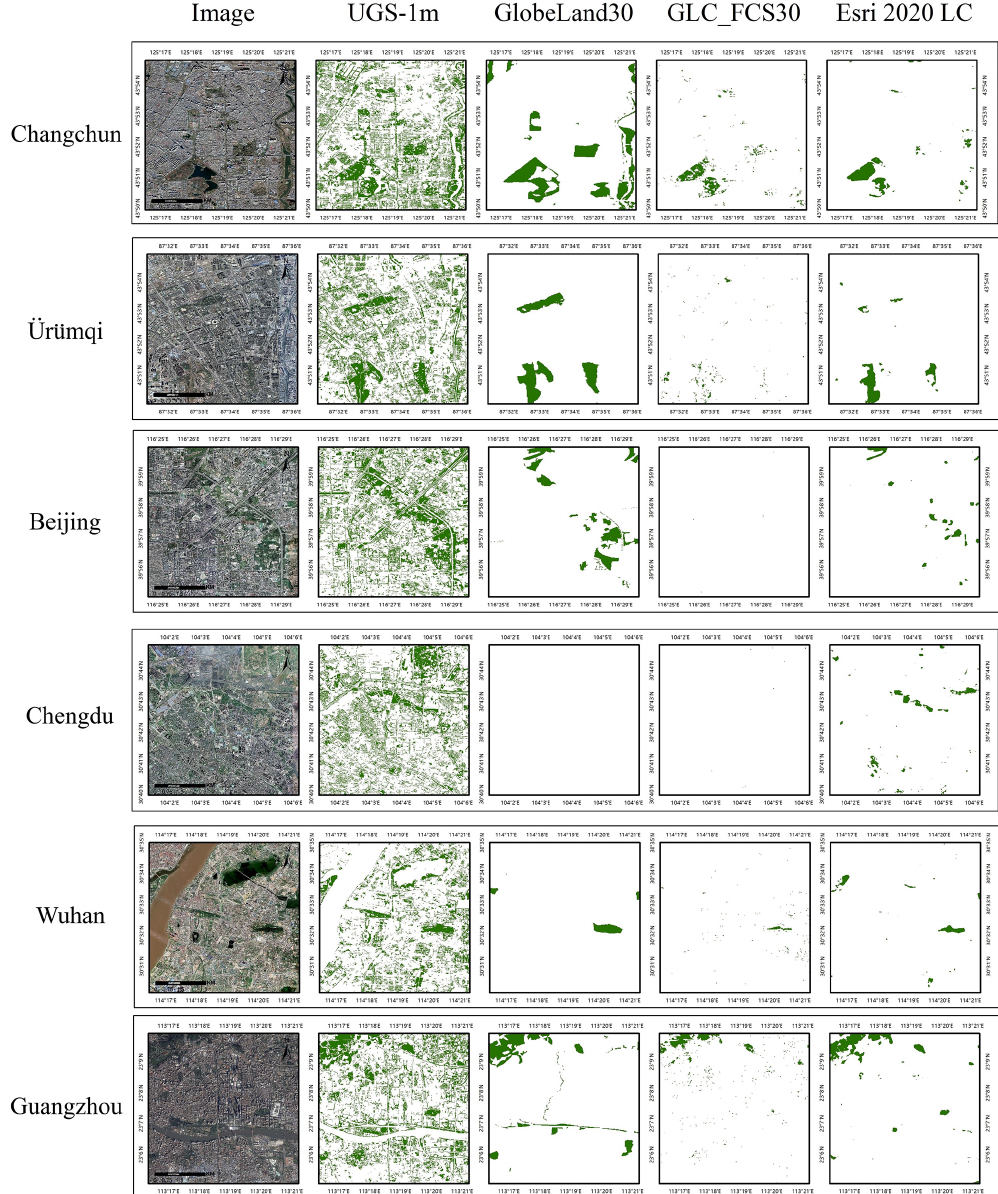
Figure 16. Visualization comparisons between UGS-1m, GlobeLand30 (Chen and Chen, 2018), GLC_FCS30 (Zhang et al., 2021), and Esri 2020 LC (© 2021 Esri). Images are from © Google Earth